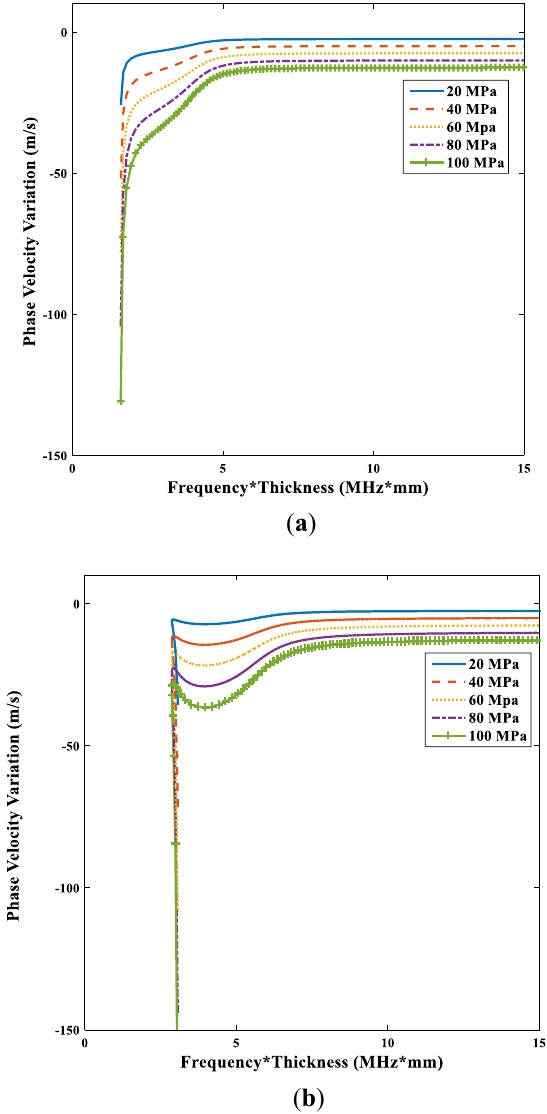
Figure 4 Dispersion curves variation for Lamb wave propagating along different uniform tensile stress of 20 MPa, 40 MPa, 60 MPa, 80 MPa, and 100 MPa: ( a) for A1 mode and ( b) for S1 mode